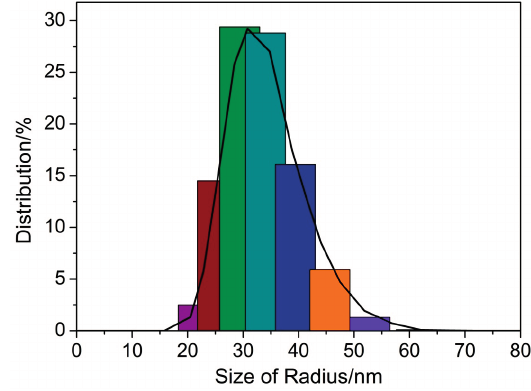
Figure 3. SN particles size and their distribution.